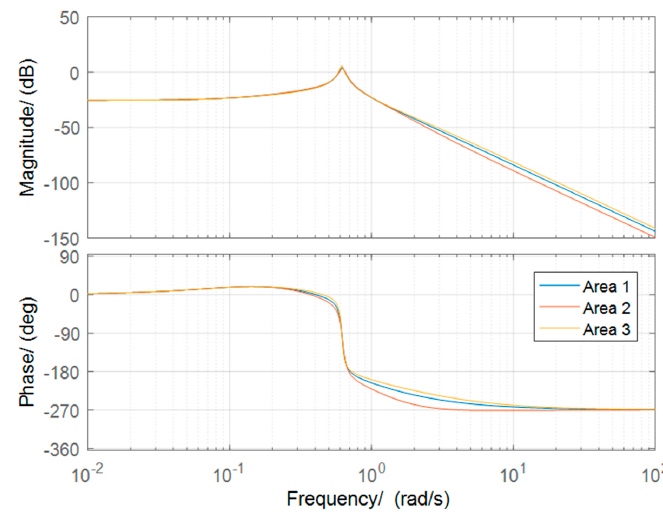
Figure 4. Bode figure of each area control system.